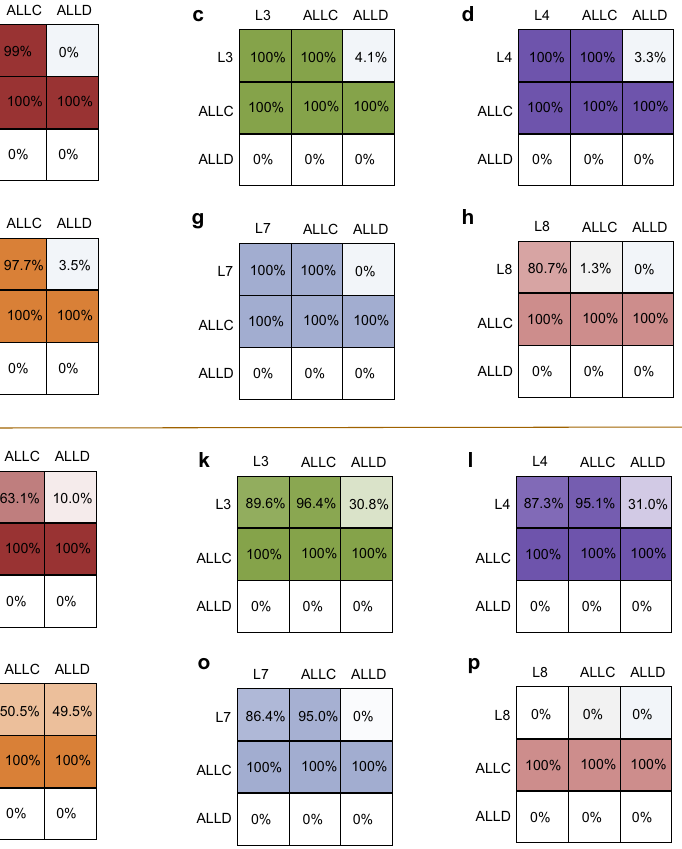
Fig. 3 | Quantitative assessment improves the accuracy of reputation assign- ments by leading eight players. We show the average overall judgments that players with the frame of reference R make of each other when comparing others ’ reputation scores with the threshold ( a – h ). As the basis for comparison to the baseline model, we use the average images that players have of each other when they use the standard binary assessment ( i – p ). We observe that quantitative assessment and more nuanced reputations lead to a clear improvement of the